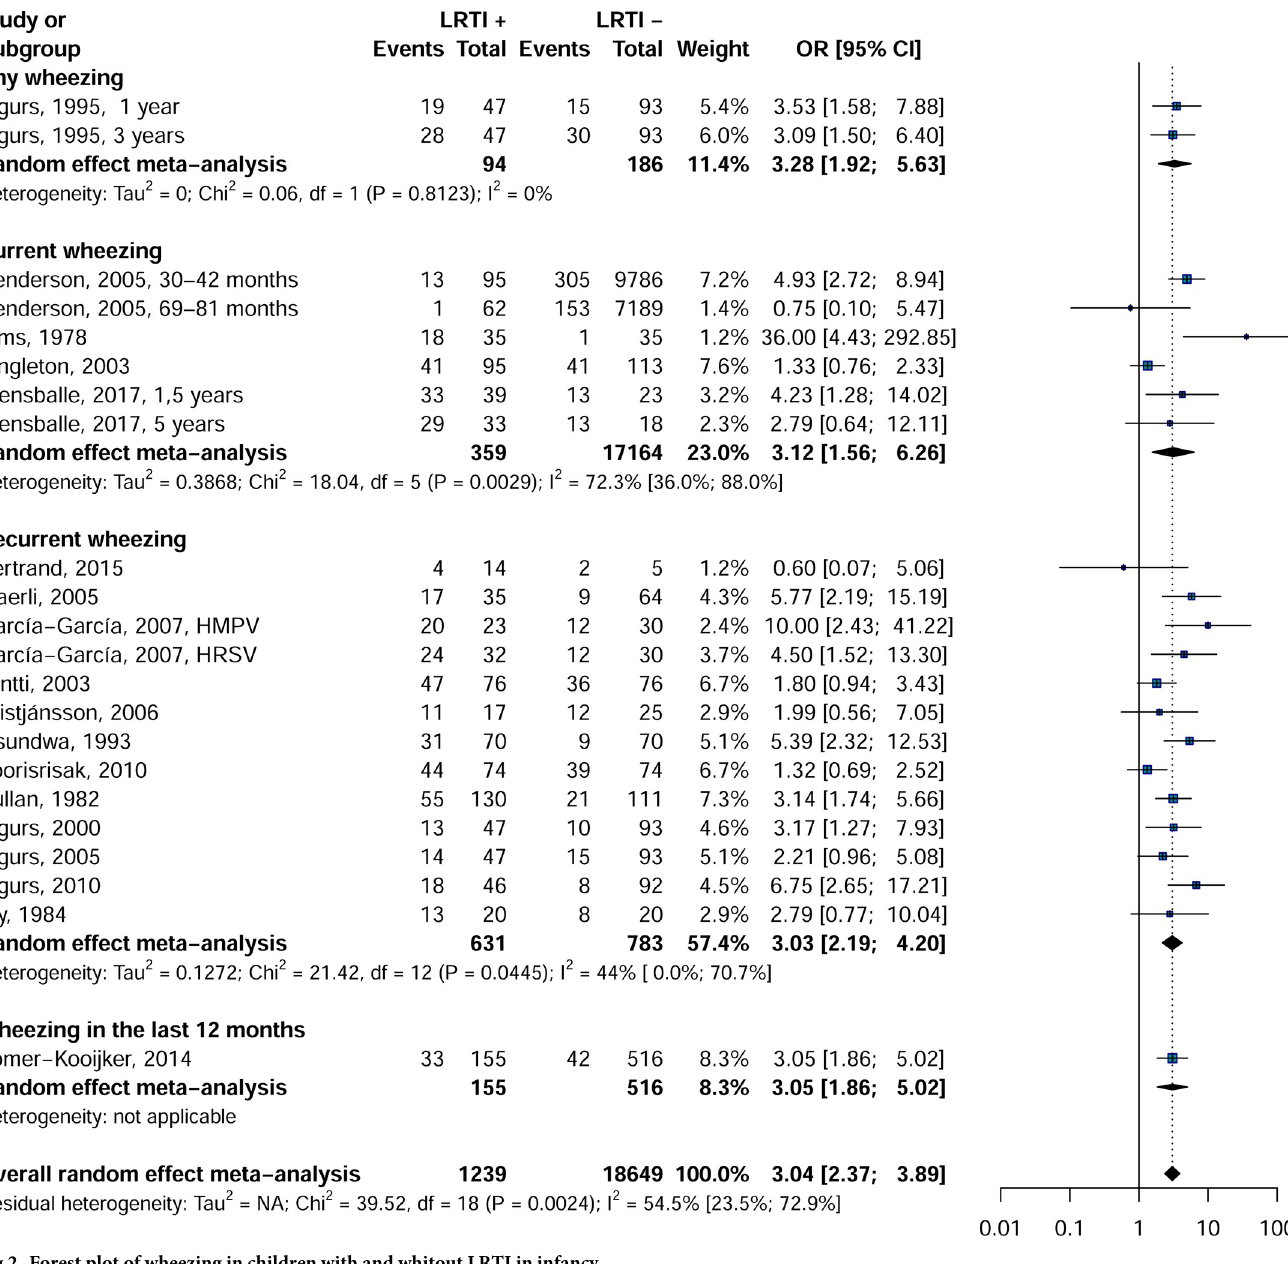
PLOS ONE | https://doi.org/10.1371/journal.pone.0249831 April 15,